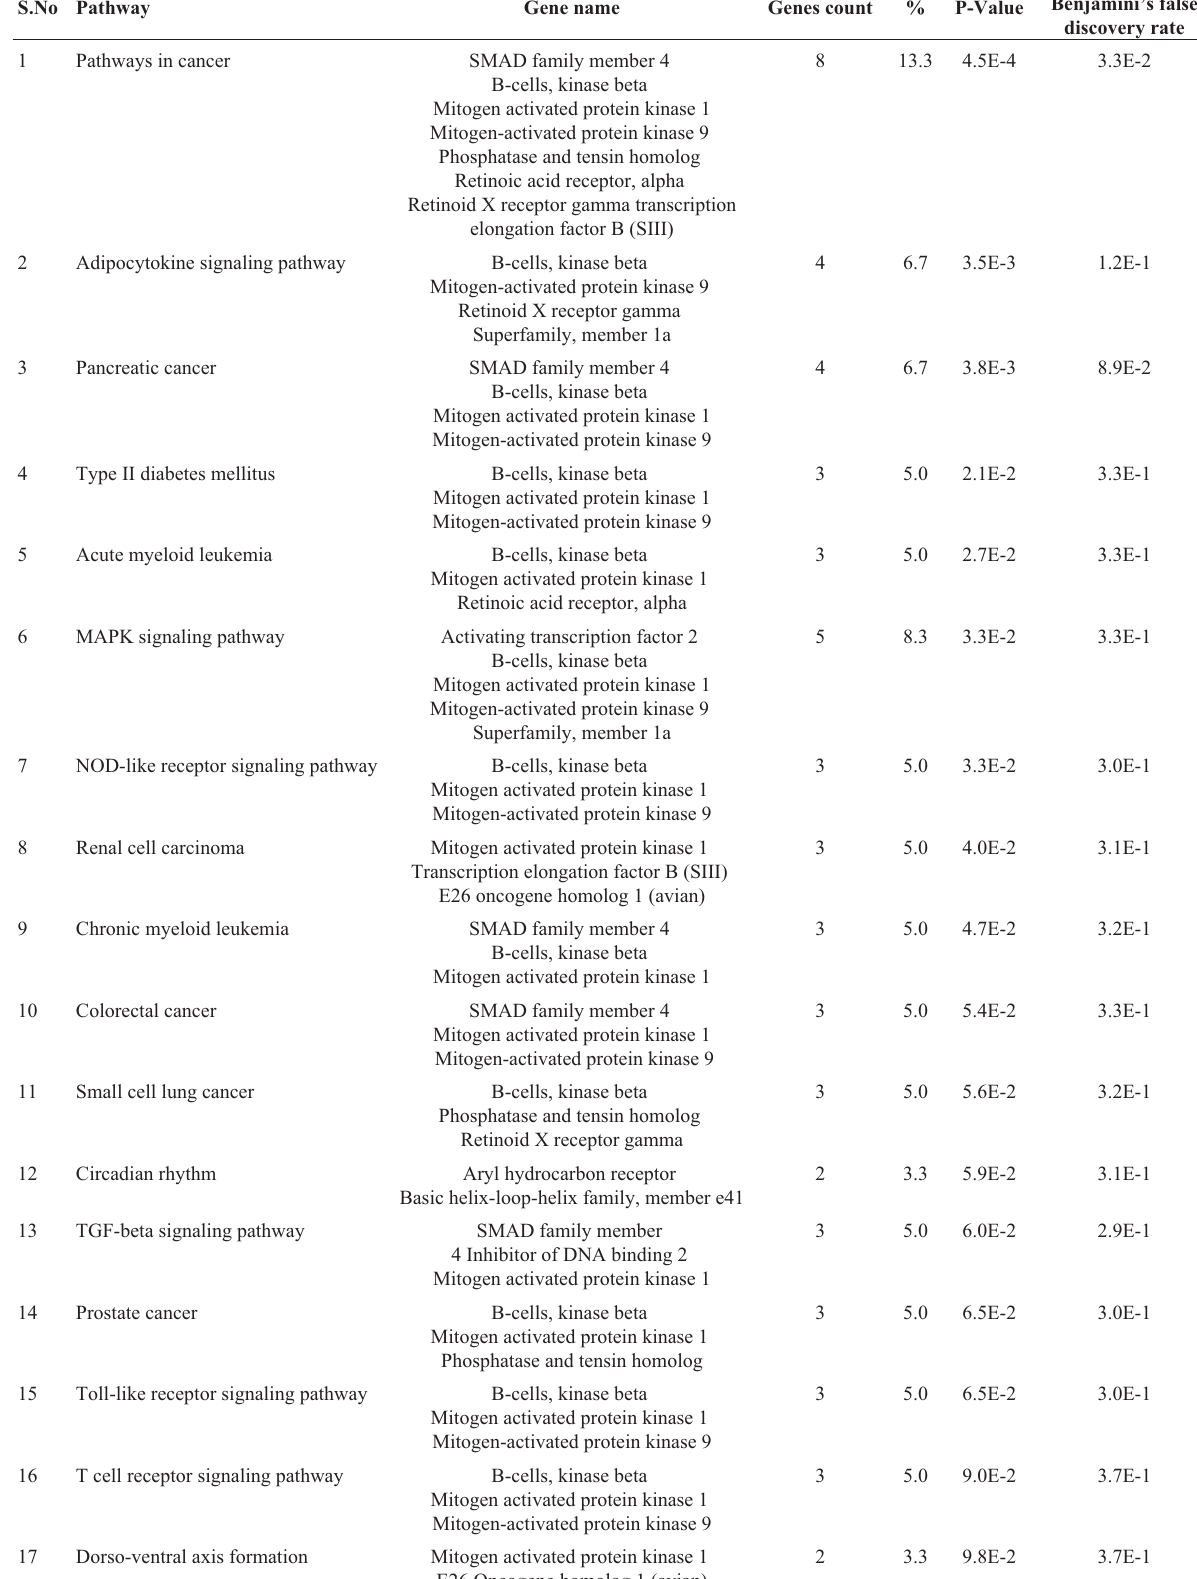
Table 2 - Regulatory pathways involving the selected genes identified by